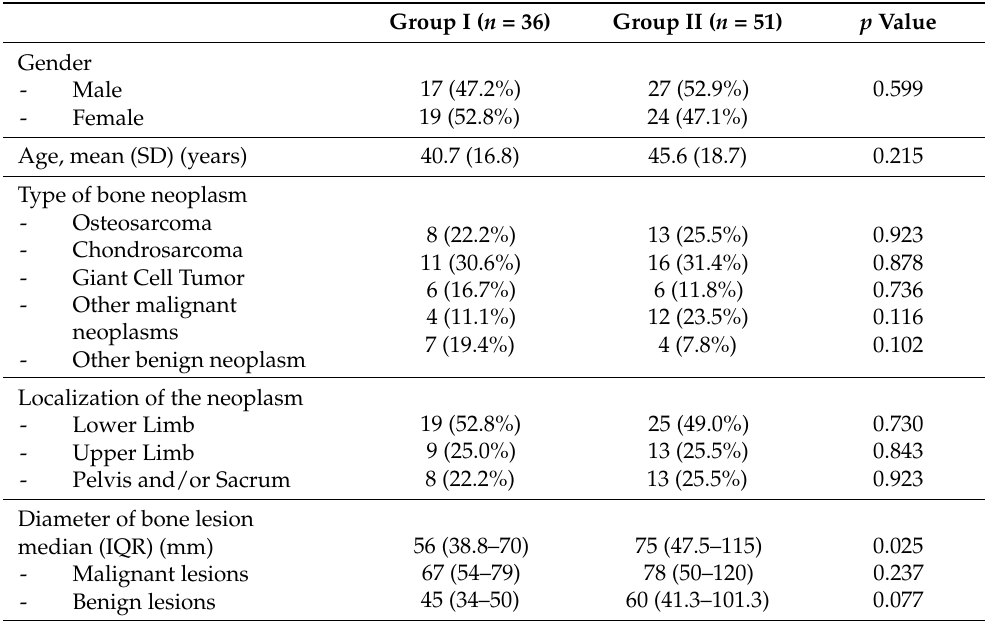
Table 1. Characteristics of patients treated for bone neoplasms before the pandemic (Group I) and during the COVID-19 pandemic (Group II). SD—Standard deviation; IQR—interquartile